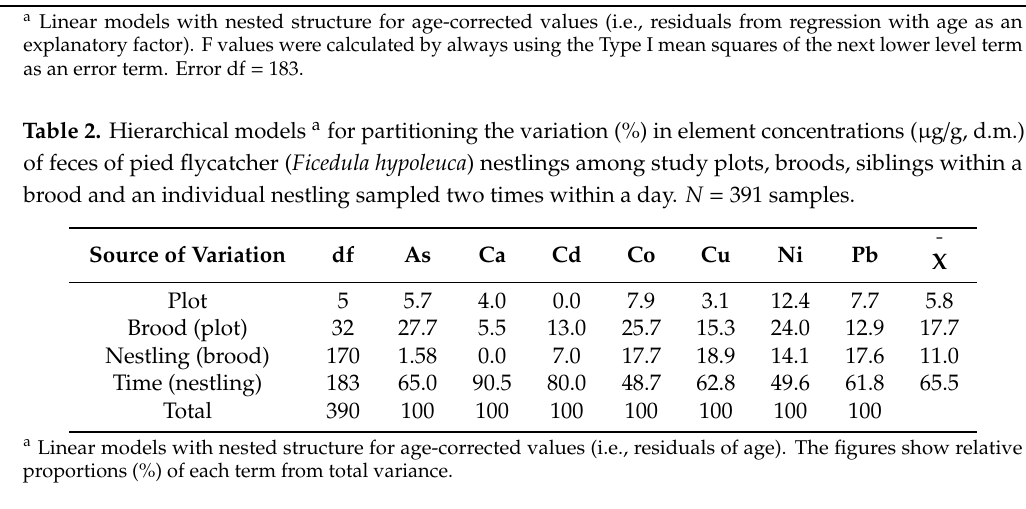
Table 3. Pearson correlations (r) a and repeatability coe ffi cients b for metal levels between successive fecal samples. Repeatability is calculated both for individual and brood level. n